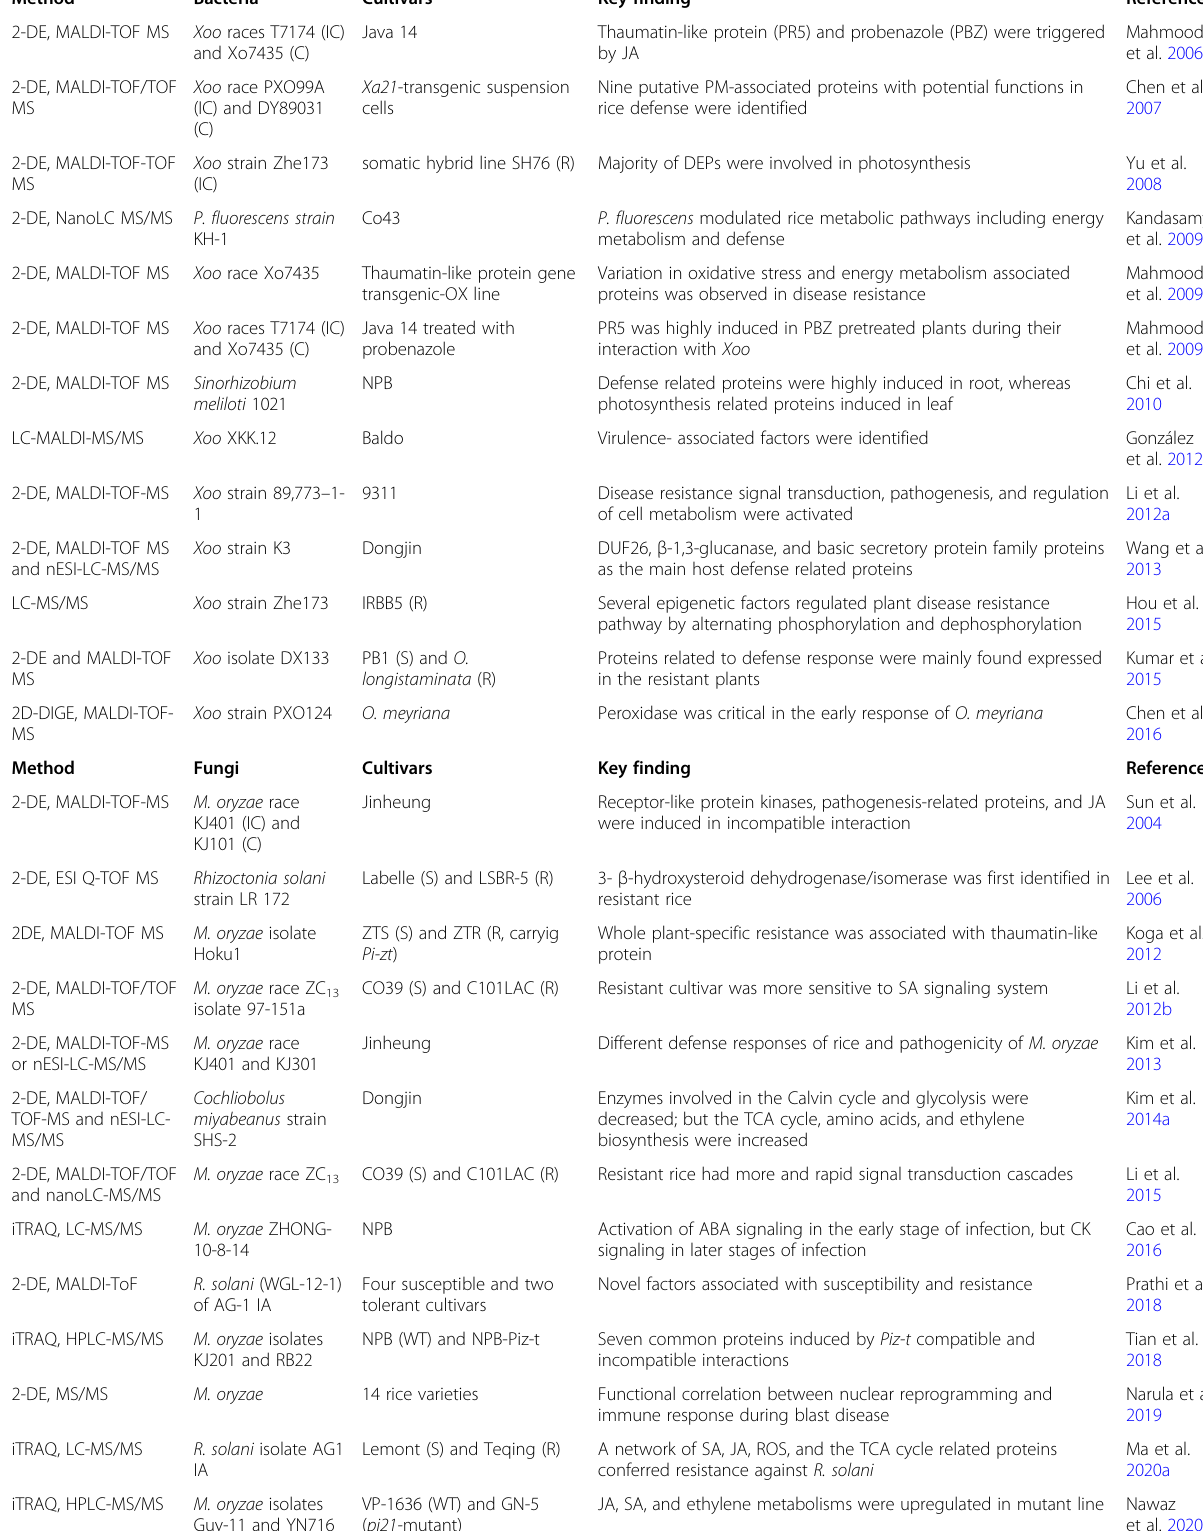
Table 1 Global proteomics studies investigating biotic stress responses in